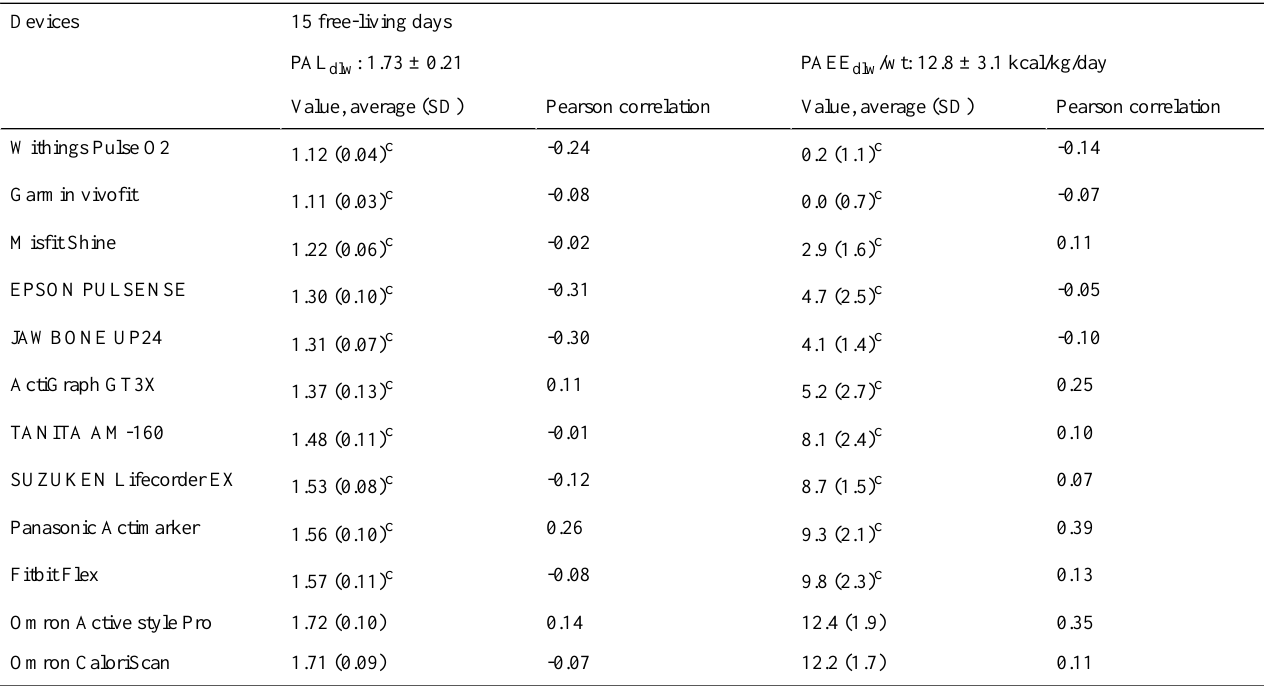
Table 4. The comparison between PAL a dlw and PAL dev , PAEE b dlw /wt and PAEE dev